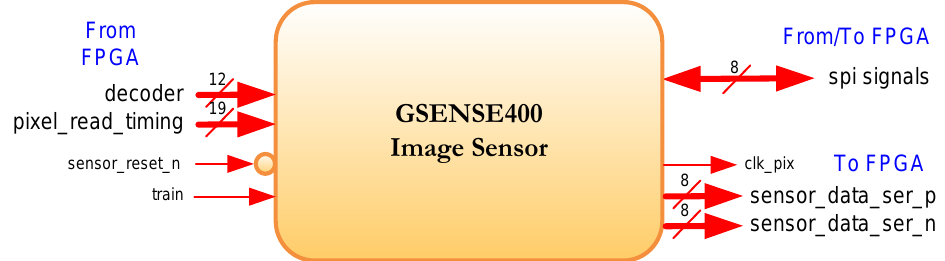
Figure 2. Signal from/to FPGA used to drive the image sensor.